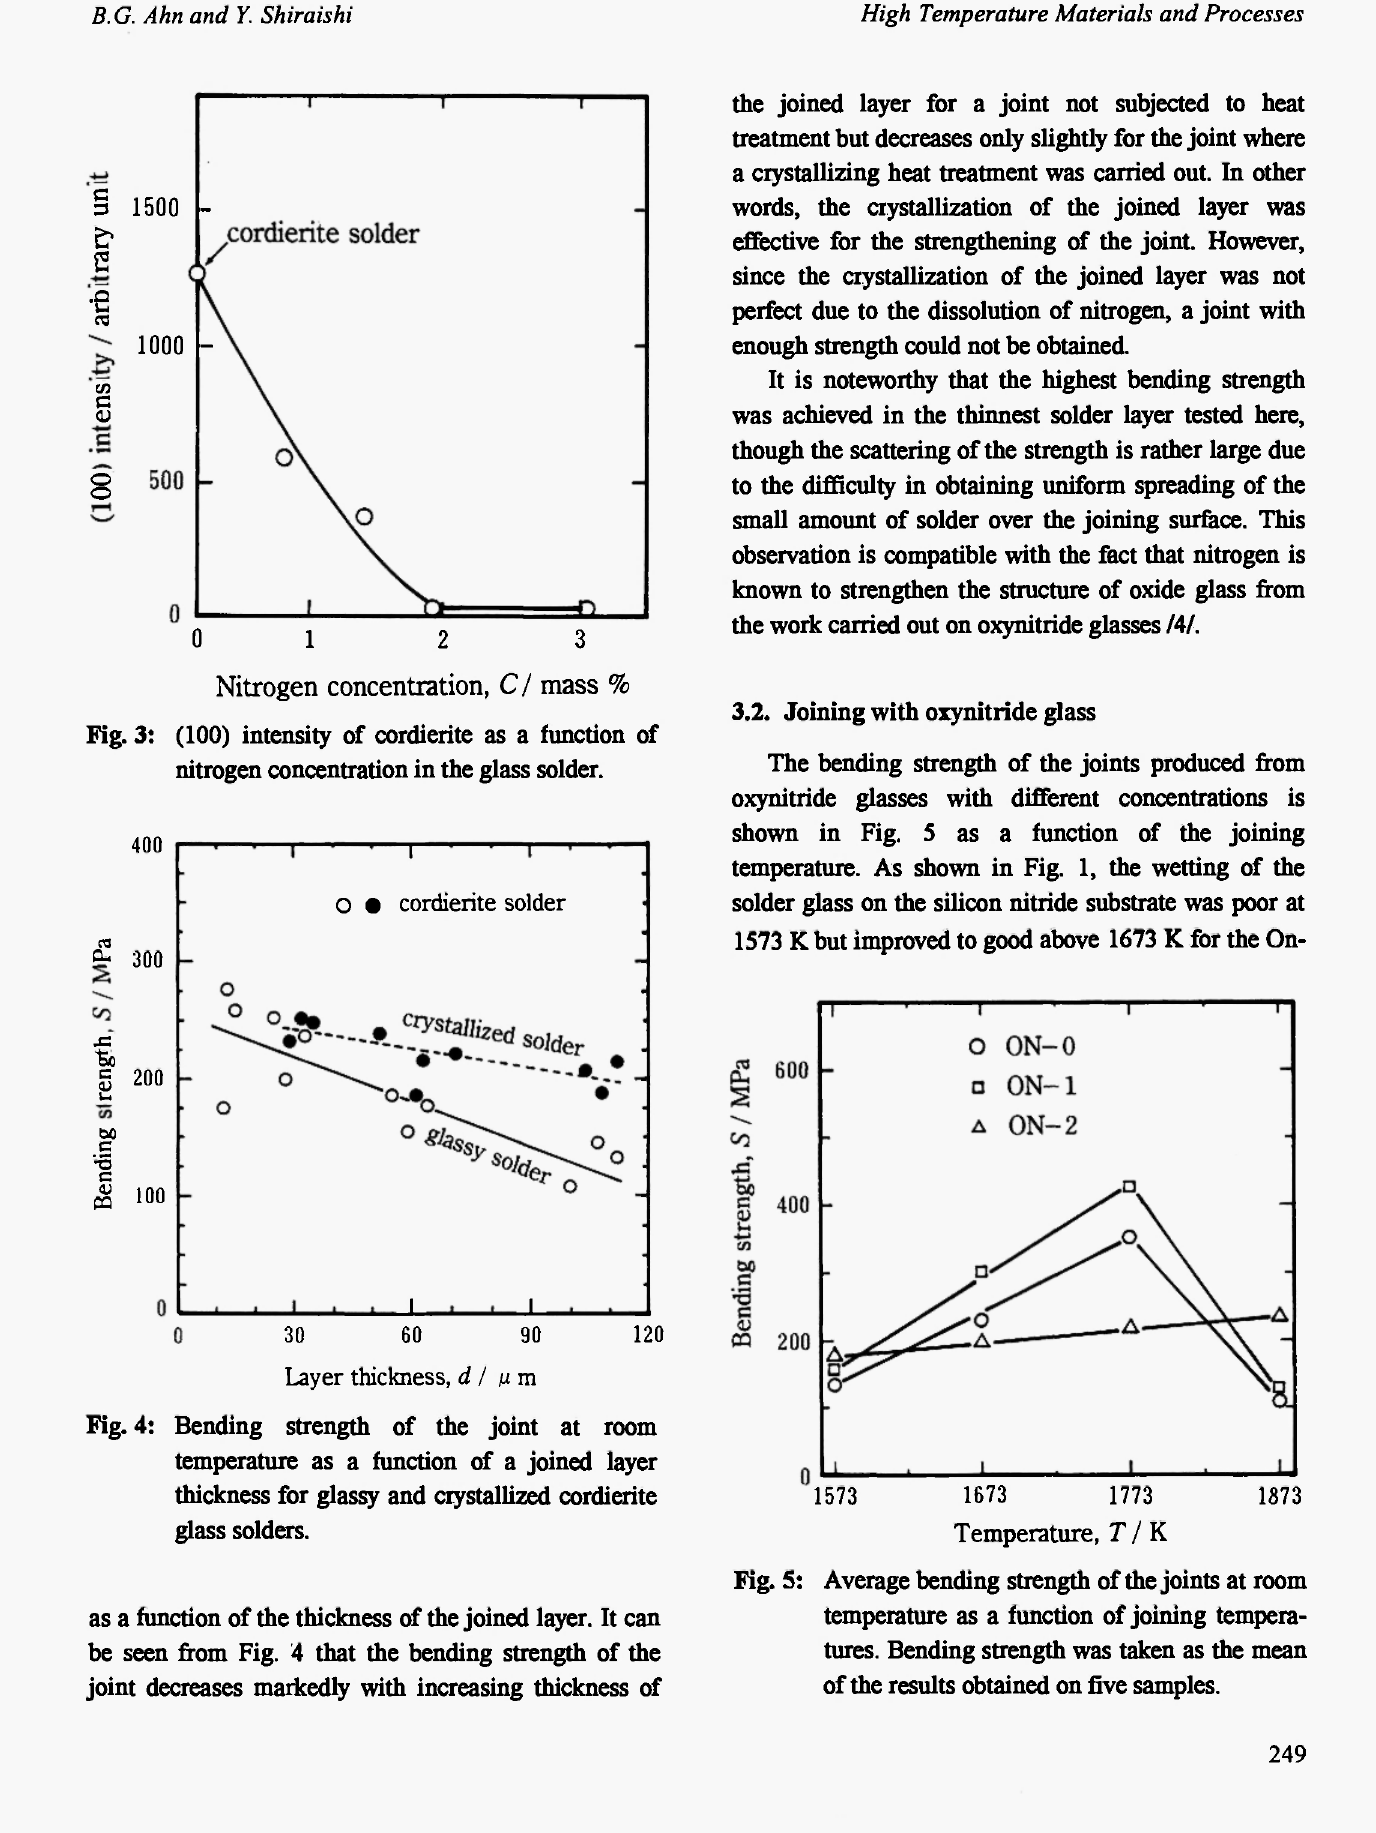
Fig. 5: Average bending strength of the joints at room temperature as a function of joining tempera- tures. Bending strength was taken as the mean of the results obtained on five